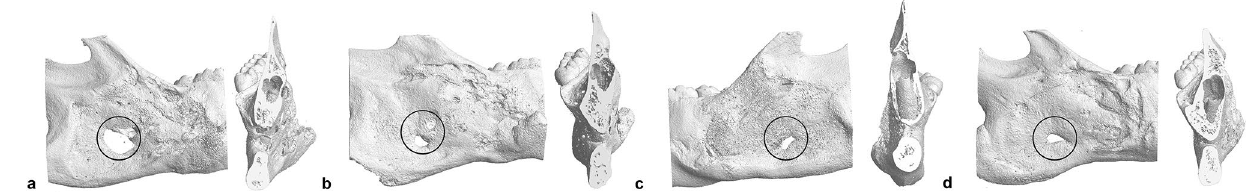
Figure 8. 3D reconstructed images of the C1 ( a ), C2 ( b ), E1 ( c ), and E2 ( d ) groups. Images show the enhanced bone healing in the round defect in the E1 and E2